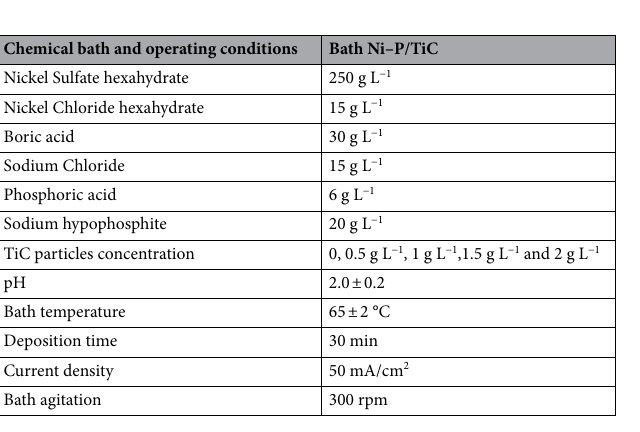
Table 1. Optimized bath composition and parameters for co-electrodeposition of Ni–P–TiC composite coatings.